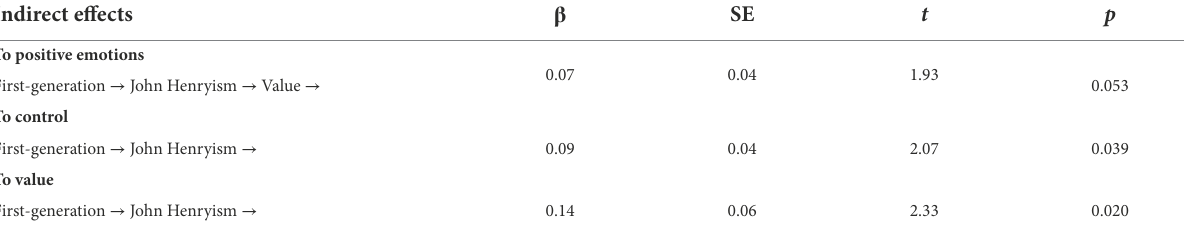
TABLE 6 Significant indirect